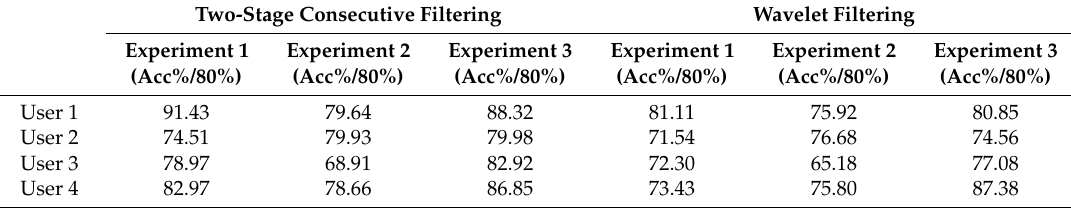
Table 10. Classification performance obtained from IMU and 3-axial acceleration sensors: filtering comparison.